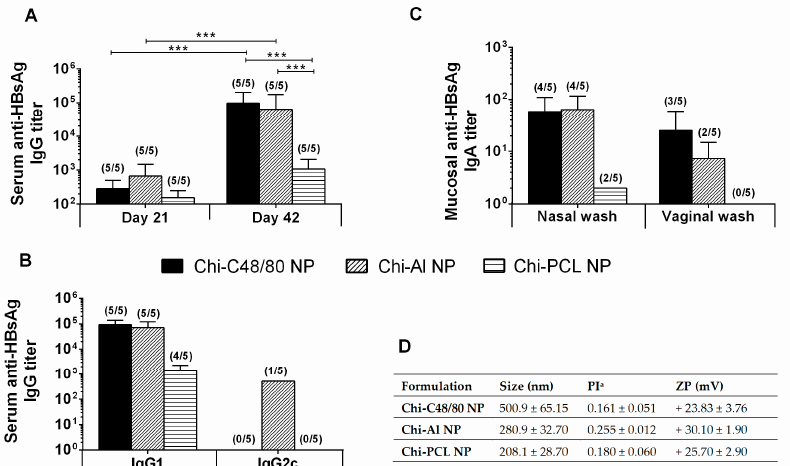
Figure 9. Immune profile of C57BL/6 mice after intranasal immunization. Serum anti-HBsAg IgG ( A ), IgG1 and IgG2c ( B ) and mucosal IgA ( C ) titers obtained with 10 µ g HBsAg loaded into Chi-C48/80 NPs, Chi-Al NPs, or Chi-PCL NPs. Blood was collected by submandibular lancet method on Days 21 and 42, and nasal and vaginal washes were collected on Day 42. Numbers above bars represent the number of mice in which antibody levels were detected. Data (mean ± SD) correspond to responder mice of each group. Table with summary of nanoparticle size, polydispersity index, and zeta potential of the formulations used during the immunization studies ( D ).